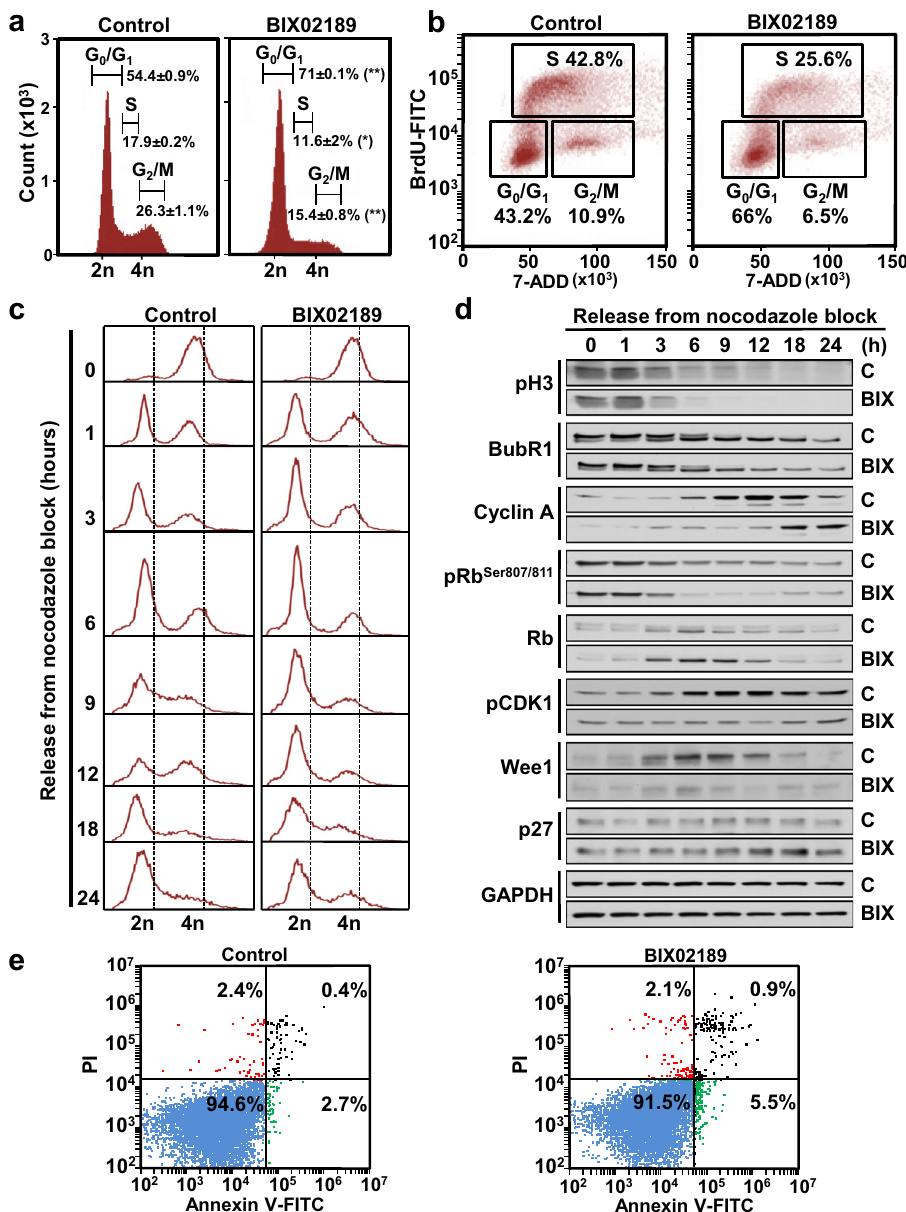
Fig. 5 In fl uence of MEK5 activity-inhibition on cell cycle progression. a Cell cycle pro fi le of H460 cells treated with 5 µM BIX02189 and analyzed by FACS at 24 h. Results are expressed as mean percentage of cells in each cell cycle phase ± SD of an experiment that was repeated three times. * p ≤ 0.05; ** p ≤ 0.01 for the statistical comparison between the same cell cycle phases of control or BIX02189-treated samples. Exact p -values are shown in Supplementary Table 1d. b BrdU incorporation was coupled to 7-ADD staining and measured at 24 h using the FITC BrdU Flow Kit to precisely de fi ne the percentage of cells undergoing DNA synthesis. c H460 cells were synchronized in mitosis by nocodazole. Mitotic cells were released from nocodazole block in the absence or presence of 5 µM BIX02189 for the indicated times and the effect of the drug on the different phases of cell cycle was analyzed by FACS, and d proteins implicated in cell cycle progression were evaluated by western blotting with the indicated antibodies. GAPDH was used as loading control. e H460 cells were either untreated or treated with 5 μ M BIX02189 for 72 h and apoptosis was analyzed by Annexin V-FITC phosphorylated histone H3 as well as phosphorylated BubR1, two 1d). The drug decreased DNA synthesis of asynchronous H460 proteins whose phosphorylation is used as readout for cells in cells, as demonstrated by pulse labeling with BrdU followed by mitosis (Fig. 5d). One hour after release from the nocodazole cytometric analysis (Fig. 5b). The delay in cell cycle progression block, a substantial amount of cells had progressed into G1, and was con fi rmed in cell cycle synchronization experiments. H460 such progression was unaffected by BIX02189 (Fig. 5c), suggesting cells were synchronized in mitosis by incubation with nocodazole, that exit from mitosis is unaffected by the drug. The histograms and then released in the absence or presence of BIX02189. Parallel obtained at 9 and 12 h after release showed that BIX02189-treated cultures of cells were analyzed cytometrically (Fig. 5c) and by cultures accumulated in the G1 phase and did not ef fi ciently western blotting (Fig. 5d). H460 cells were arrested in M upon progress along the S phase when compared to untreated cells. incubation with nocodazole as demonstrated by accumulation of